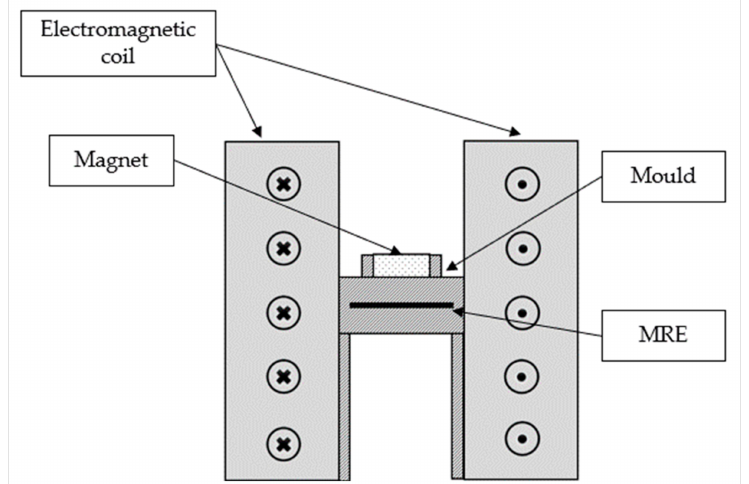
Figure 2. Schematic diagram of the electromagnetic coil set